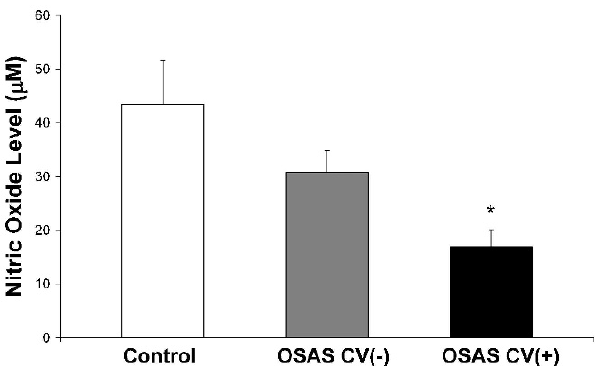
Figure 1 - Comparison of nitric oxide levels in control subjects and in obstructive sleep apnea patients without (obstructive sleep apnea syndrome cardiovascular (-)) and with cardiovascular diseases [obstructive sleep apnea syndrome cardiovascular ( + )) * p , 0.05 compared with the control group.